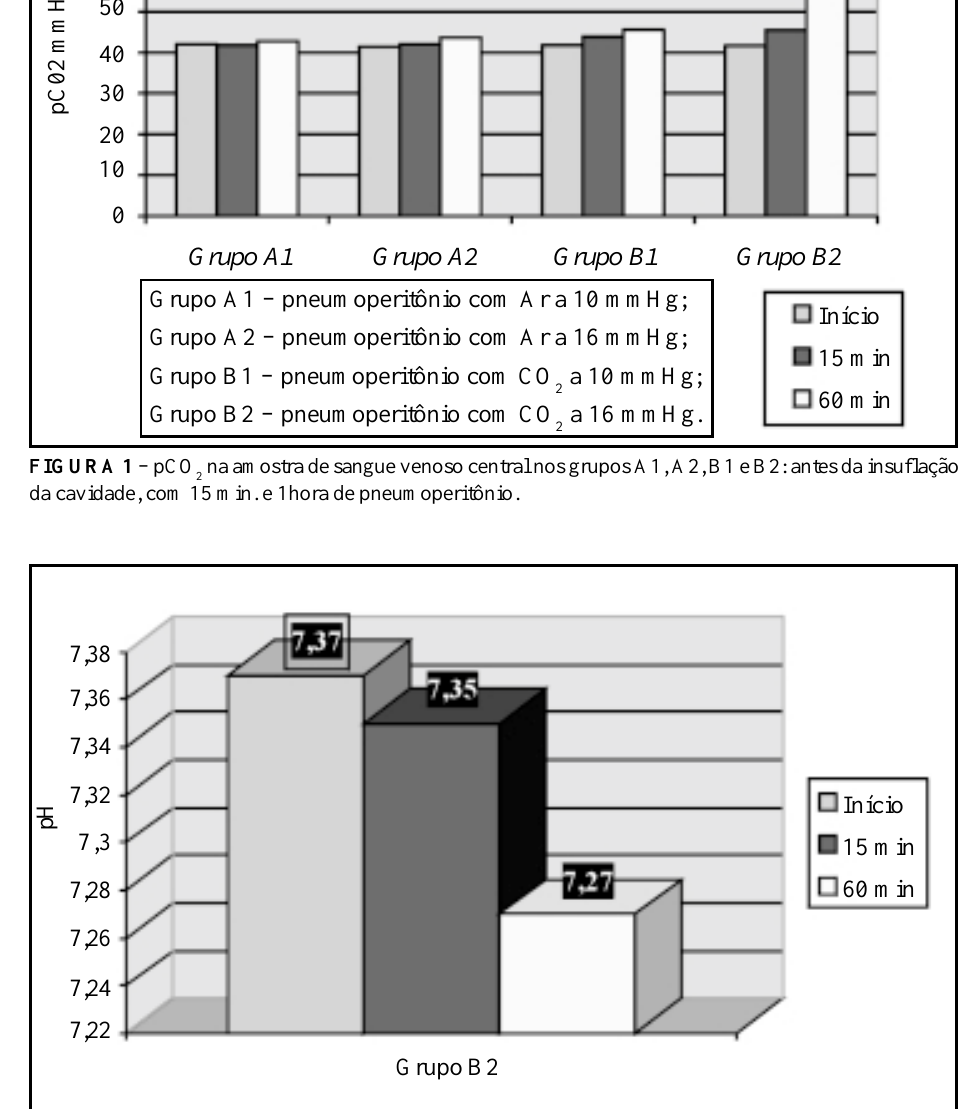
FIGURA 2 – Variação do pH em pneumoperitônio de CO com 15 min. e 1hora de